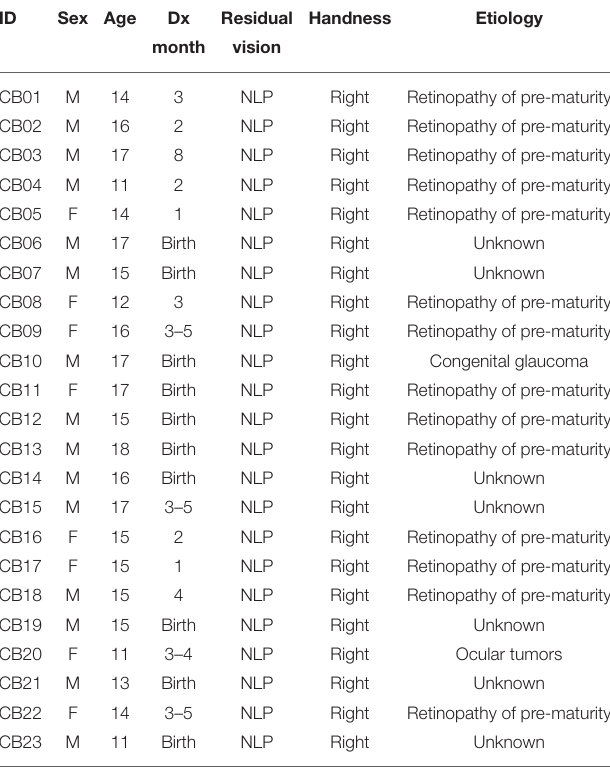
TABLE 1 | Demographic data of congenital blind